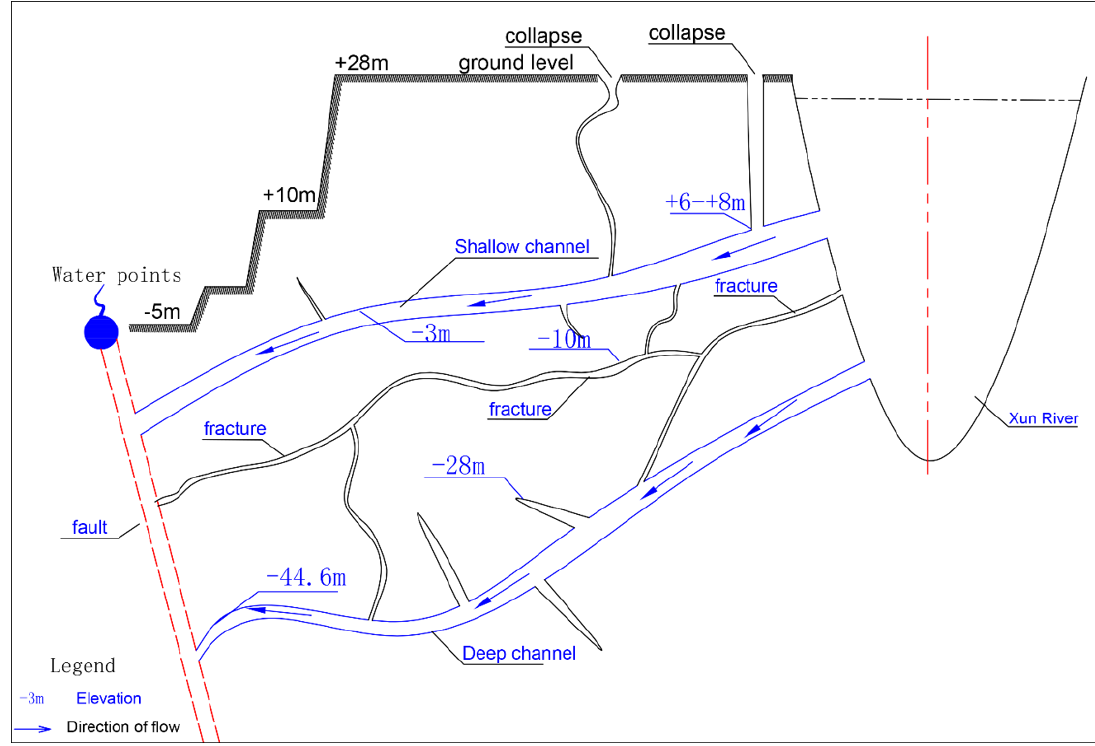
Figure 9. Inferred underground runoff map.